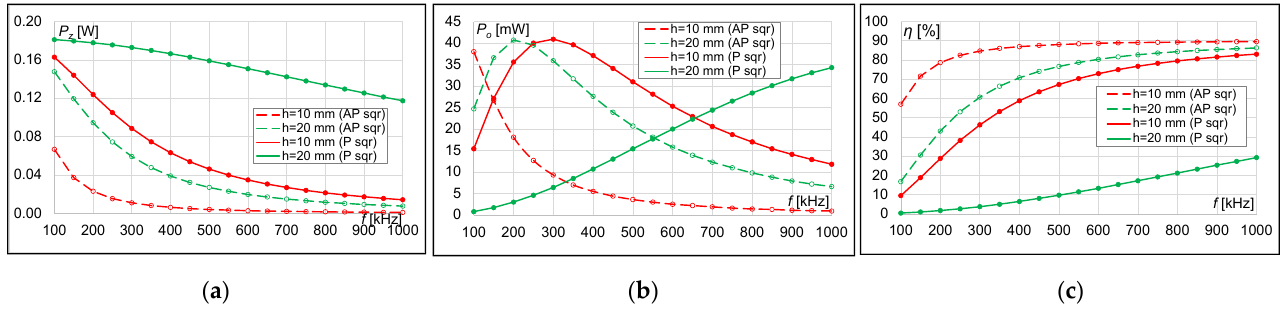
Figure 15. Results for square coils with r = 20 mm and the number of turns n = 40 at two distances ( h = 10 mm and h = 20 mm): ( a ) transmitter power, ( b ) receiver power, ( c ) power transfer efficiency.